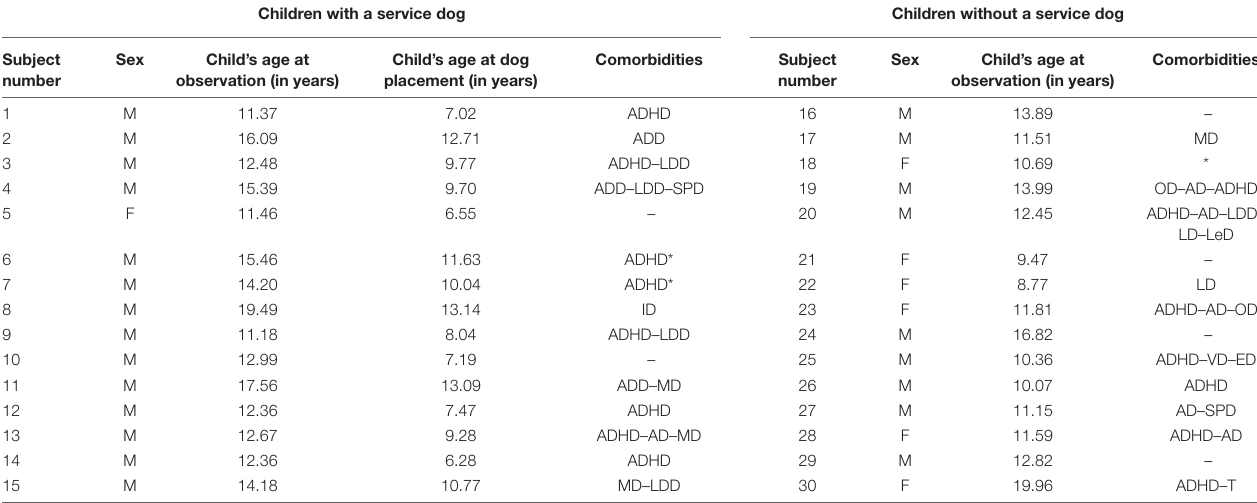
TABLE 1 | General characteristics of the children with ASD (with and without a service dog) included in the study. Children with a service dog Children without a service